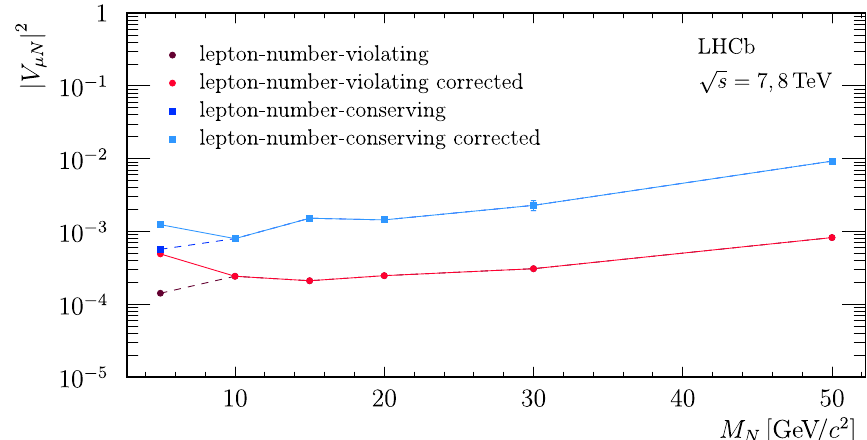
(cid:2) (cid:2) (cid:2) 2 (cid:2) V μ N